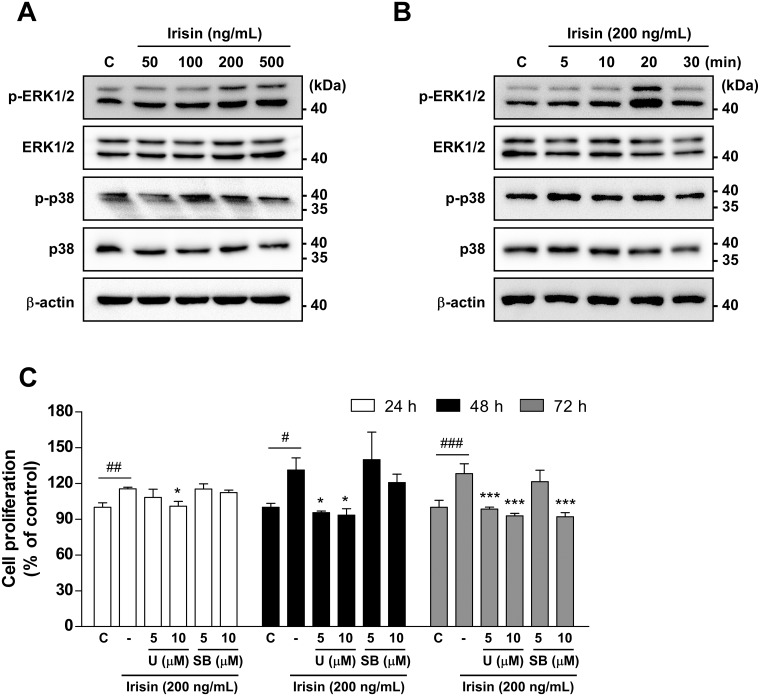
Irisin promotes C2C12 cell proliferation via activation of ERK.(A, B) Irisin phosphorylated ERK1/2 in a (A) dose-dependent and (B) time-dependent manner. Expression and phosphorylation levels of indicated proteins were determined by Western blotting. (C) Irisin-induced C2C12 cell proliferation was sensitive to inhibition of the ERK signaling pathway. Cell proliferation (%) was measured by MTS assay. Data are represented as the means ± SD (n = 3). Hash symbols (#, ##, and ###) indicate significant differences between control and irisin-treated groups (p < 0.05, 0.01, and 0.001, respectively) and asterisk symbols indicate significant differences between the irisin-treated group and the irisin and inhibitor co-treated groups (*p < 0.05 and ***p < 0.001). U, U0126 (an MEK1/2 inhibitor); SB, SB203580 (a p38 inhibitor).